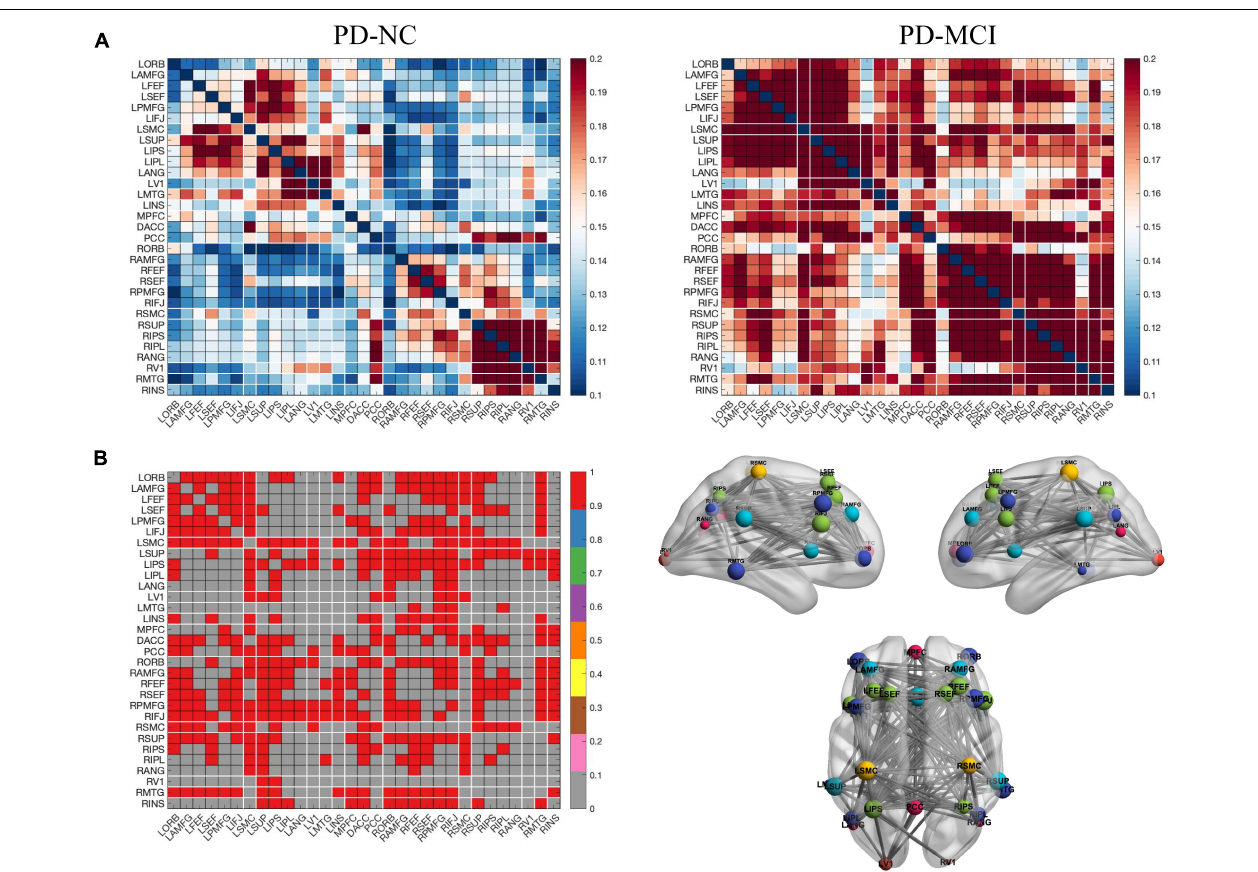
FIGURE 1 | Left and right PMFG-based functional connectivity changes in the theta frequency band under EC condition in PD-related mild cognitive impairment. (A) Functional connectivity matrices of the PD-MCI and PD-NC groups. (B) NBS analysis of group differences (PD-MCI group > PD-NC group, including the left PMFG and the right PMFG-based functional connectivity). Differential functional connectivity between the two groups (left), and 3D brain connectivity patterns showing the left side, right side, and the upper view, respectively (right). In (B) , the red matrix element represents the variant edges of the NBS analysis and the size of the node indicates the sum of the number of surviving edges for each node. EC, eyes closed; PD-MCI, Parkinson’s disease with mild cognitive impairment; PD-NC, Parkinson’s disease with normal cognition; NBS, network-based statistics; L, left; R, right; ORB, orbitofrontal cortex; AMFG, anterior division of the middle frontal gyrus; FEF, frontal eye field; SEF, supplementary eye field; PMFG, posterior division of the middle frontal gyrus; IFJ, inferior frontal junction; SMC, sensorimotor cortex; SUP, supramarginalgyrus; IPS, intraparietal sulcus; IPL, inferior parietal lobule; ANG, angular gyrus; MTG, middle temporal gyrus; V1, primary visual cortex; INS, insular cortex; MPFC, medial prefrontal cortex; DACC, dorsal anterior cingulate cortex; PCC, posterior cingulate cortex.